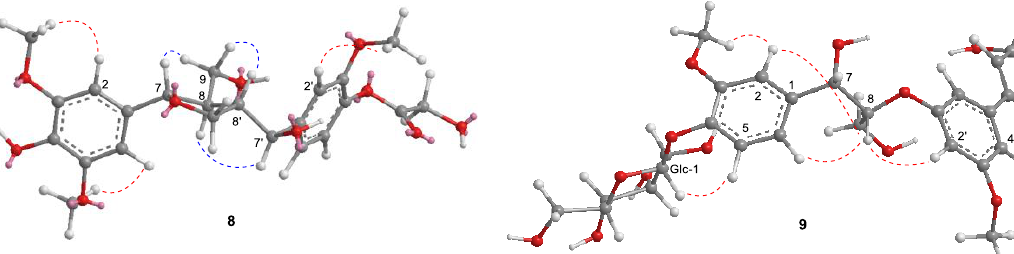
Figure 7. Key NOESY correlations (red lines) and Key ROESY correlations (blue lines) for 8 and 9 .